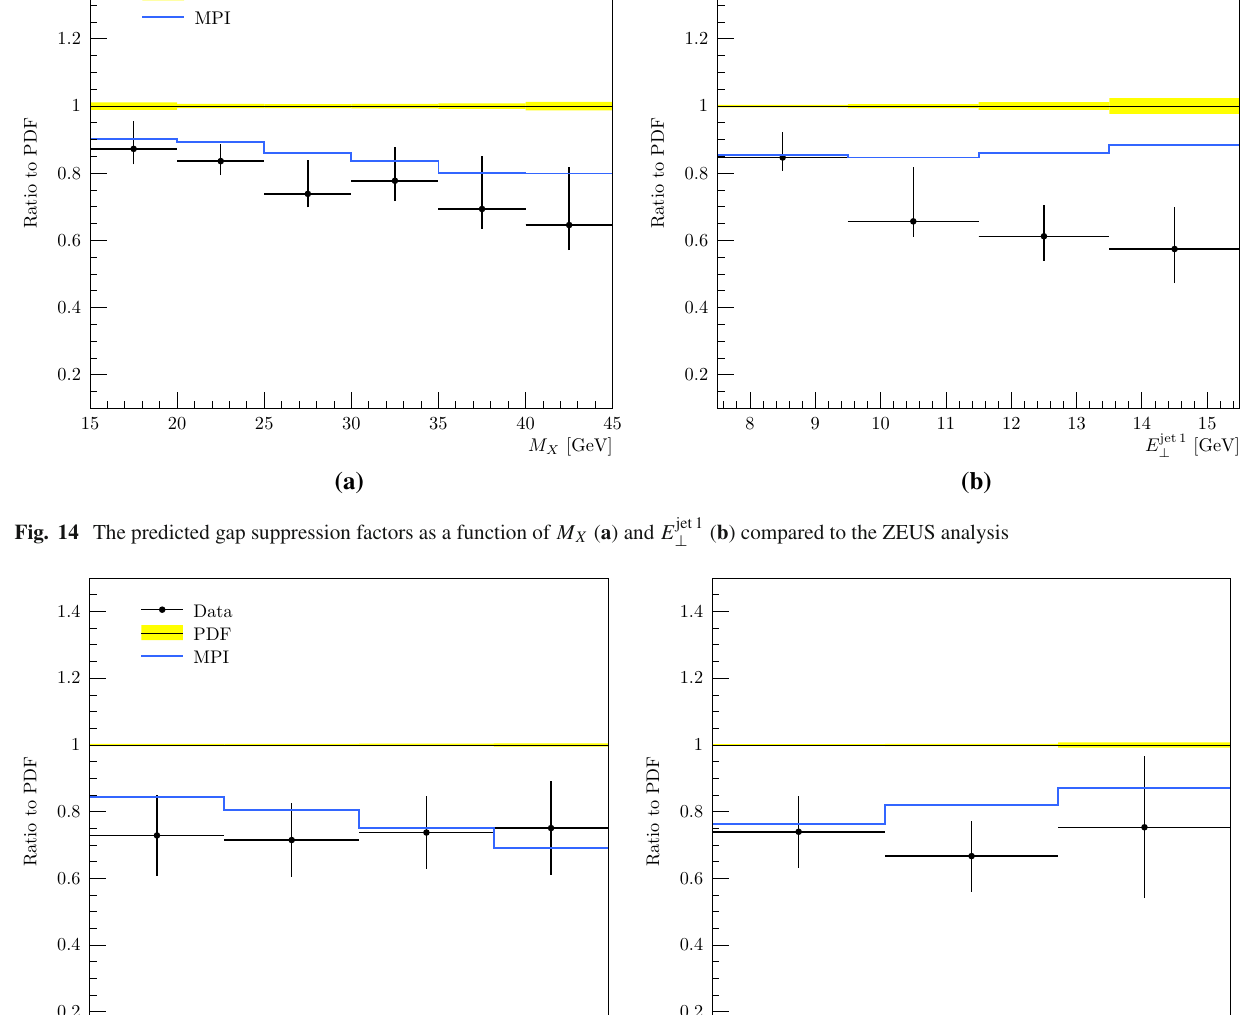
Fig. 15 The predicted gap suppression factors as a function of W ( a ) and E